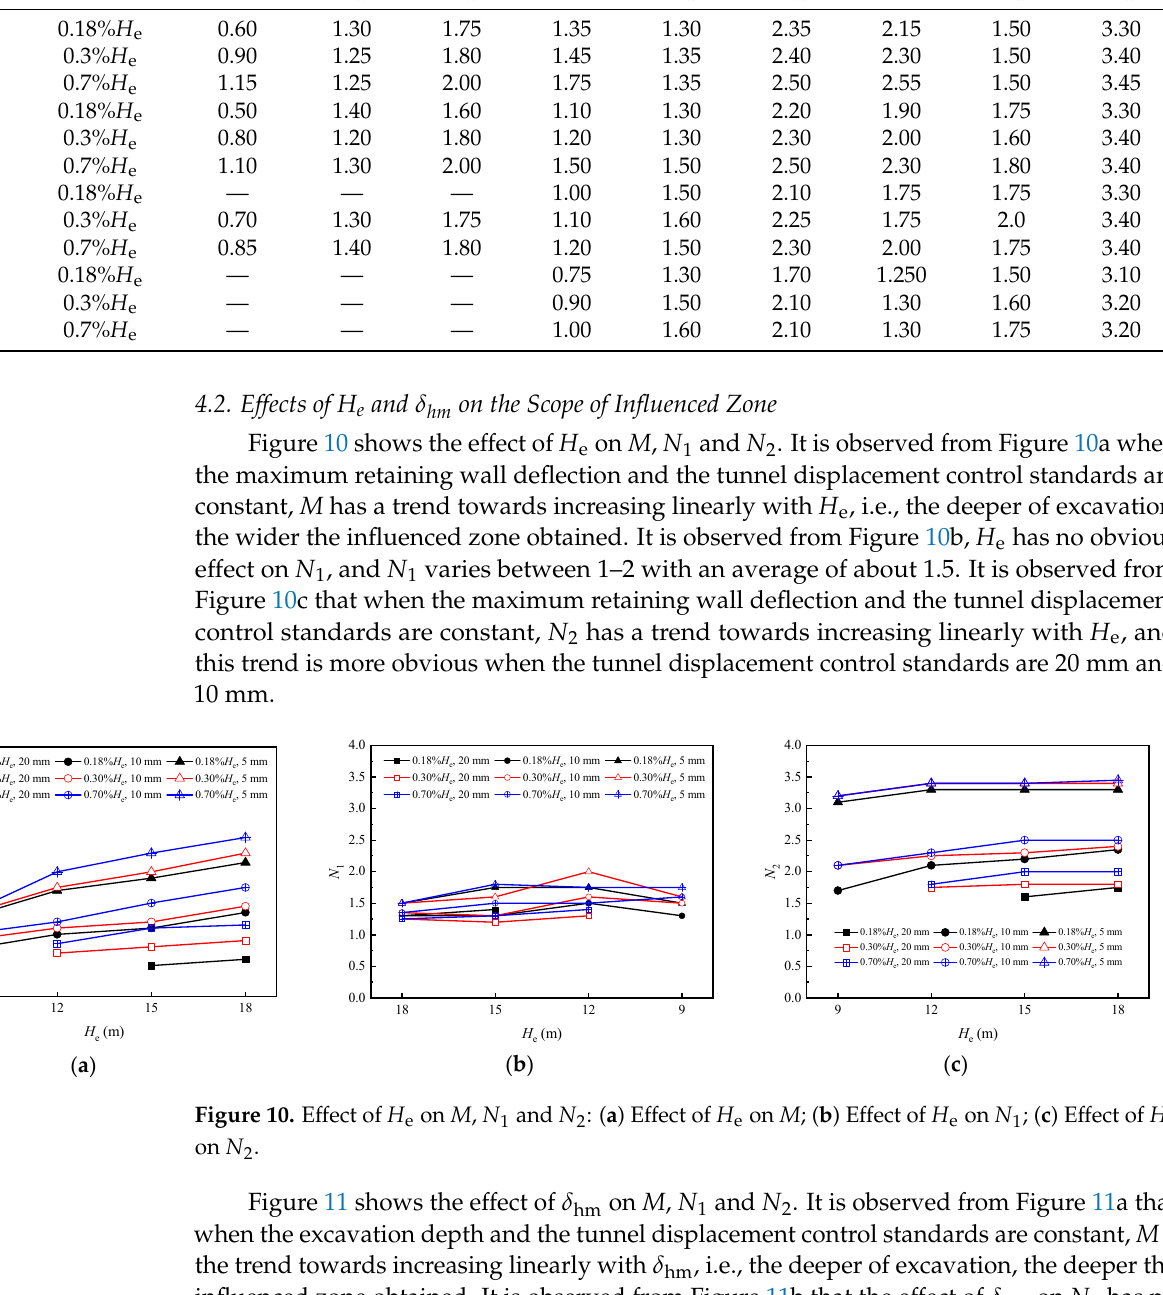
( c ) Figure 11. E ff ect of δ hm on M , N 1 and N 2 : ( a ) E ff ect of δ hm on M ; ( b ) E ff ect of δ hm on N 1 ; ( c ) E ff ect of δ hm on N 2 .